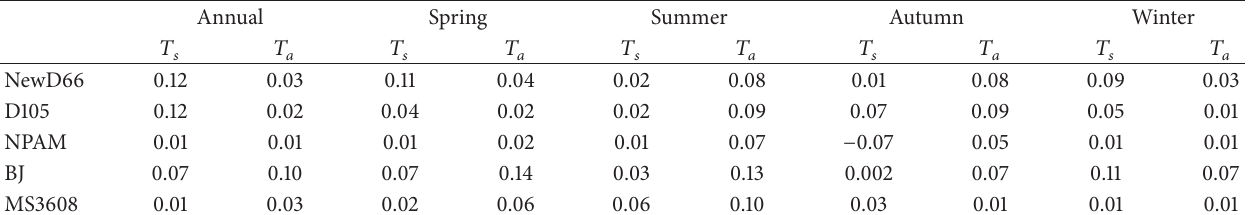
Table 2: The annual and seasonal linear trend of 𝑇 𝑠 and 𝑇 𝑎 in all sites.